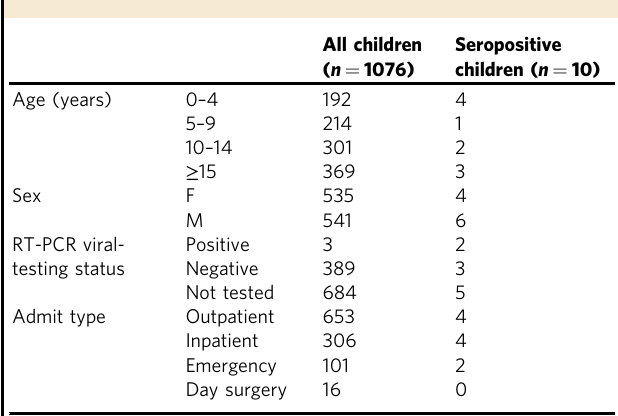
Table 1 Cohort demographics.